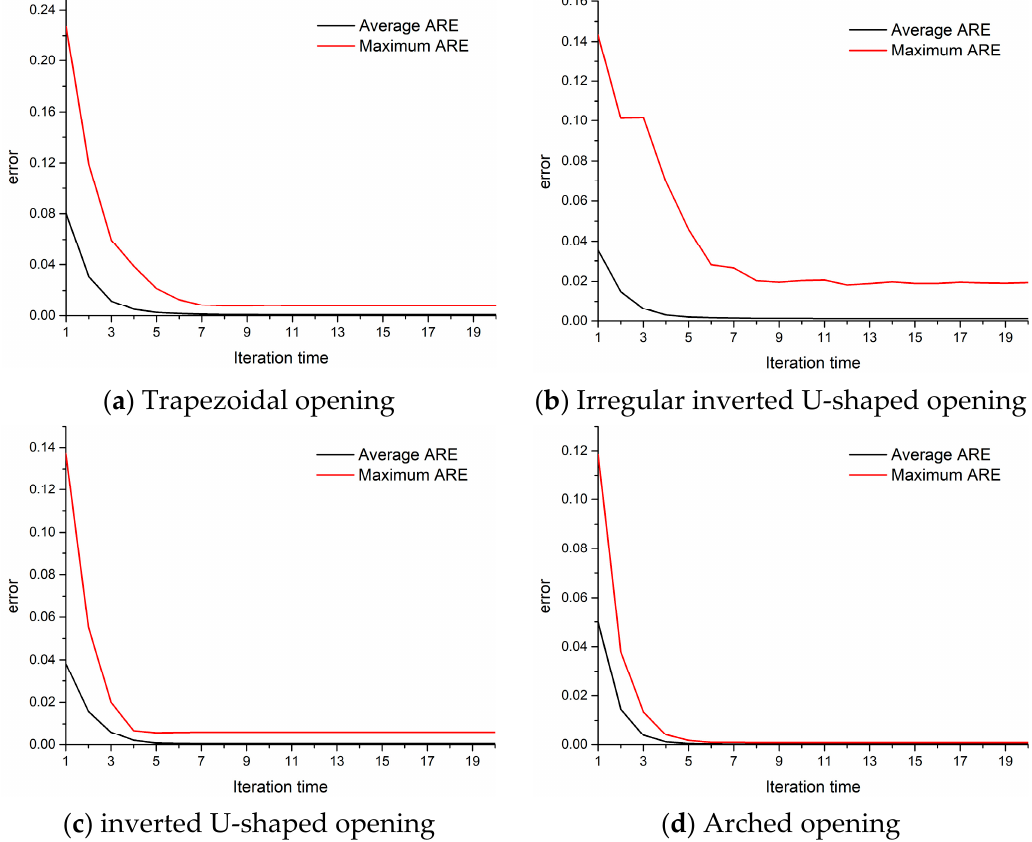
Figure 4. The curves of average ARE and maximum ARE versus iteration time